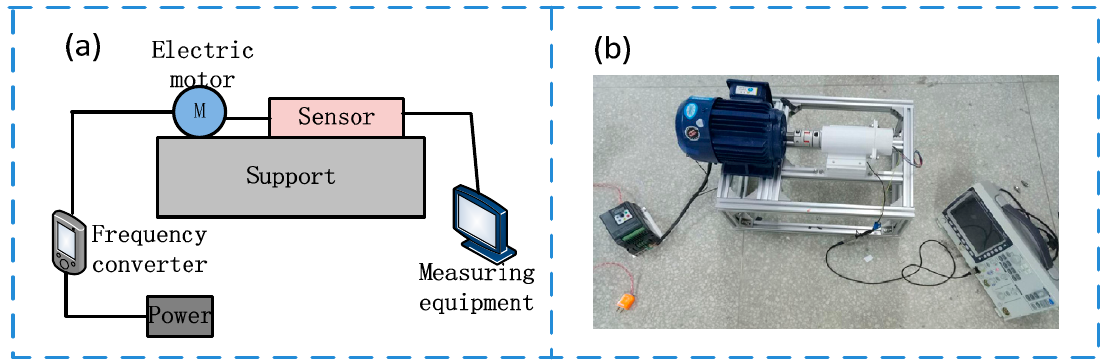
Figure 3. Schematic diagram of experimental facilities. ( a ) Composition of experimental facilities; ( b ) physical picture of experimental facilities.